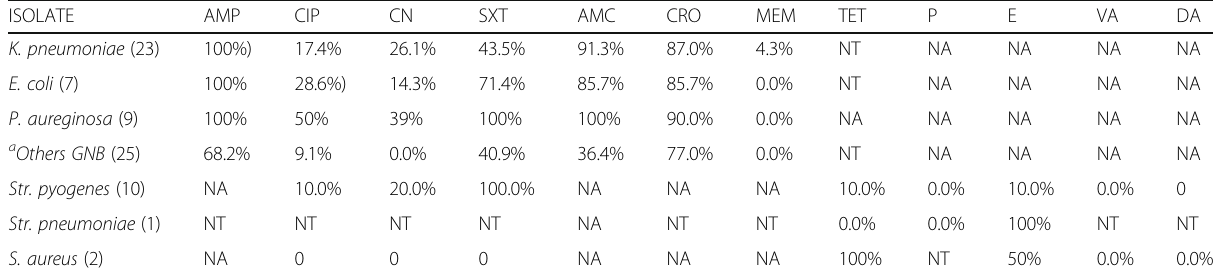
Table 3 Resistance rates for bacterial pathogens from adult patients with community acquired pneumonia between August and December 2015 in Mwanza, Tanzania